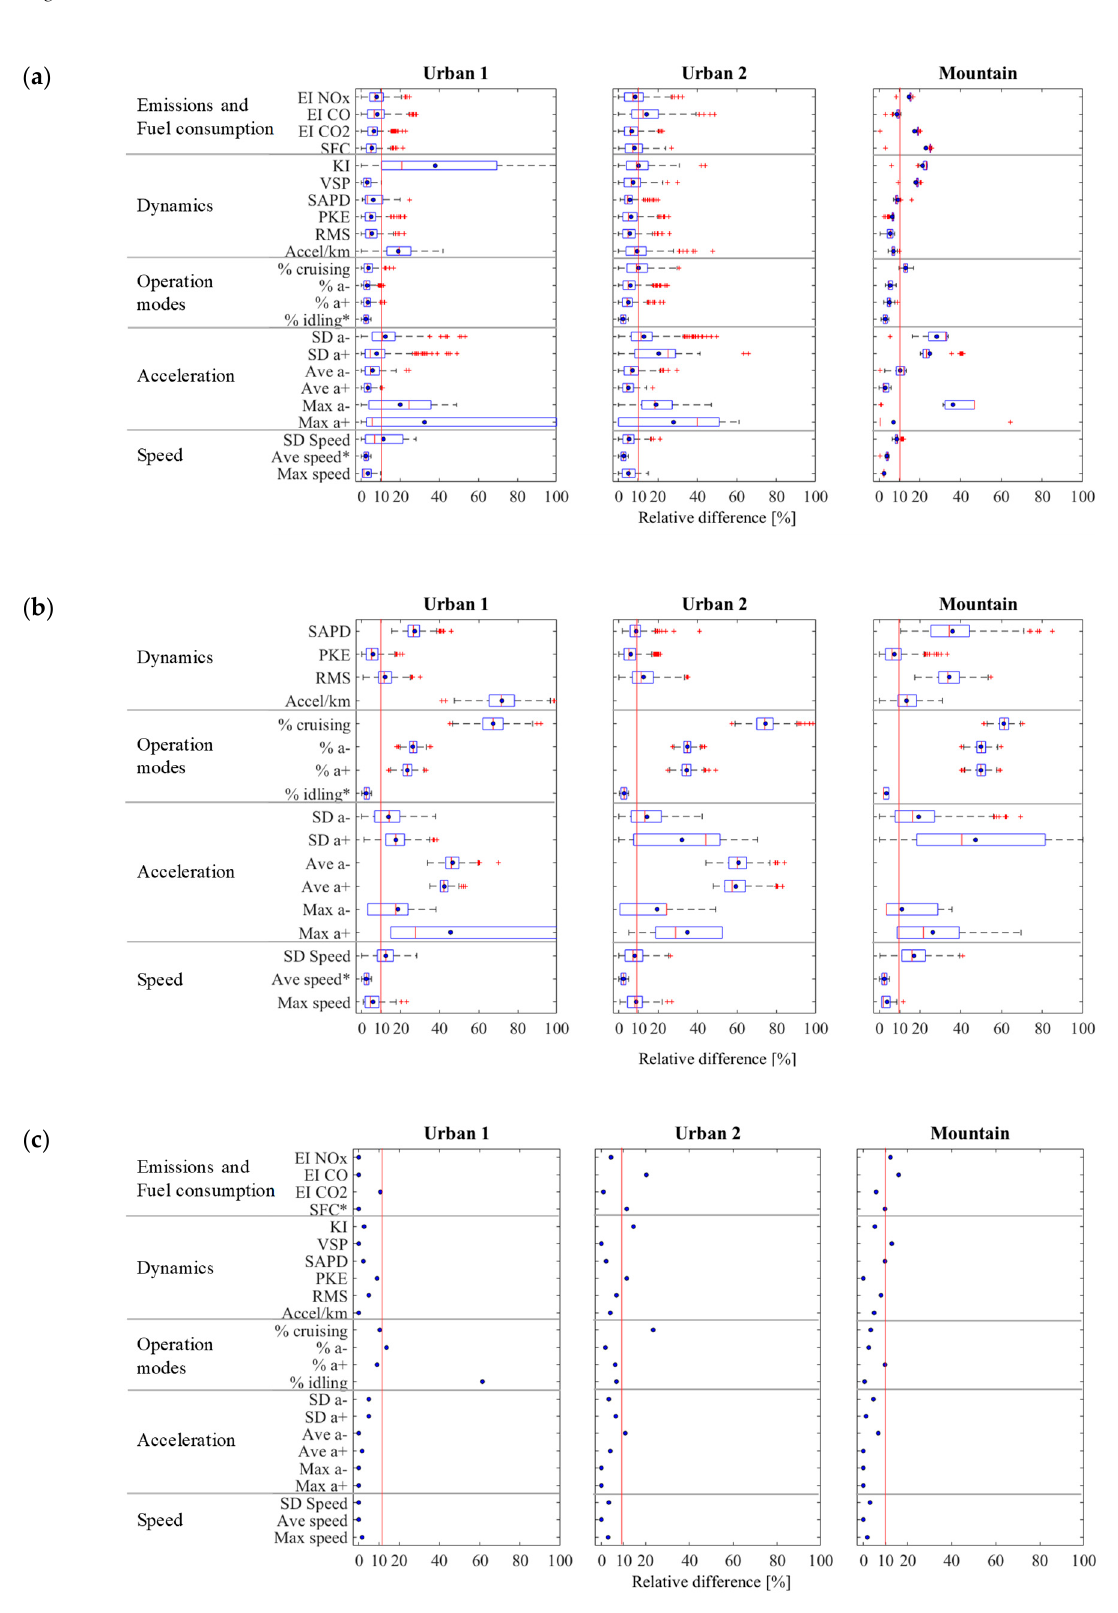
Figure 6. Boxplots of the relative differences ( RDi ) of the CPs that describe the DCs obtained by the ( a ) MT, ( b ) MCMC, and ( c ) FB methods in the Urban 1, Urban 2 and Mountain regions after 500 iterations. The ARDi are shown as blue dots, the IQRi by boxes, and the outliers by red “+” signs. The CPs used by each method as the criteria for the construction of the DC are marked with (*).